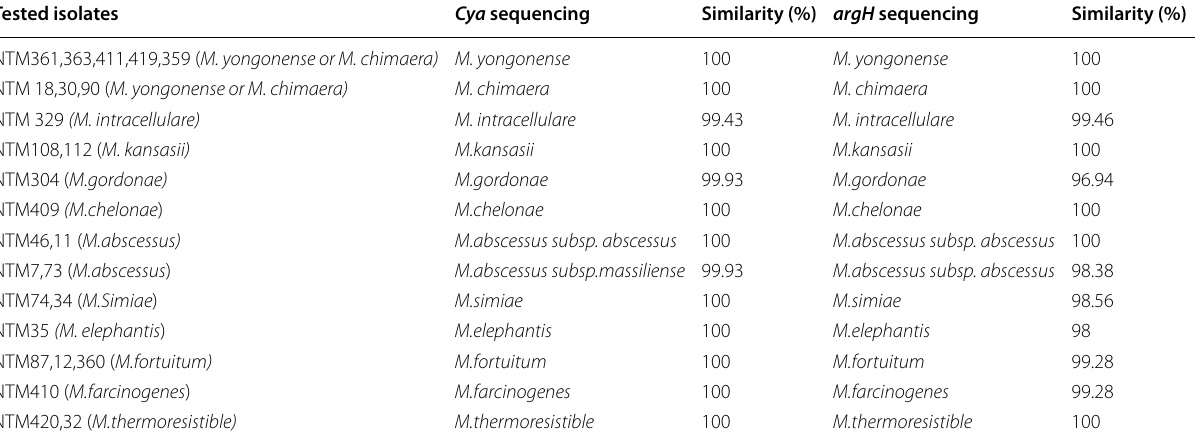
Table 3 Results of cya and argH sequencing for identification of NTM species and the similarity percentage of each isolate with the reference